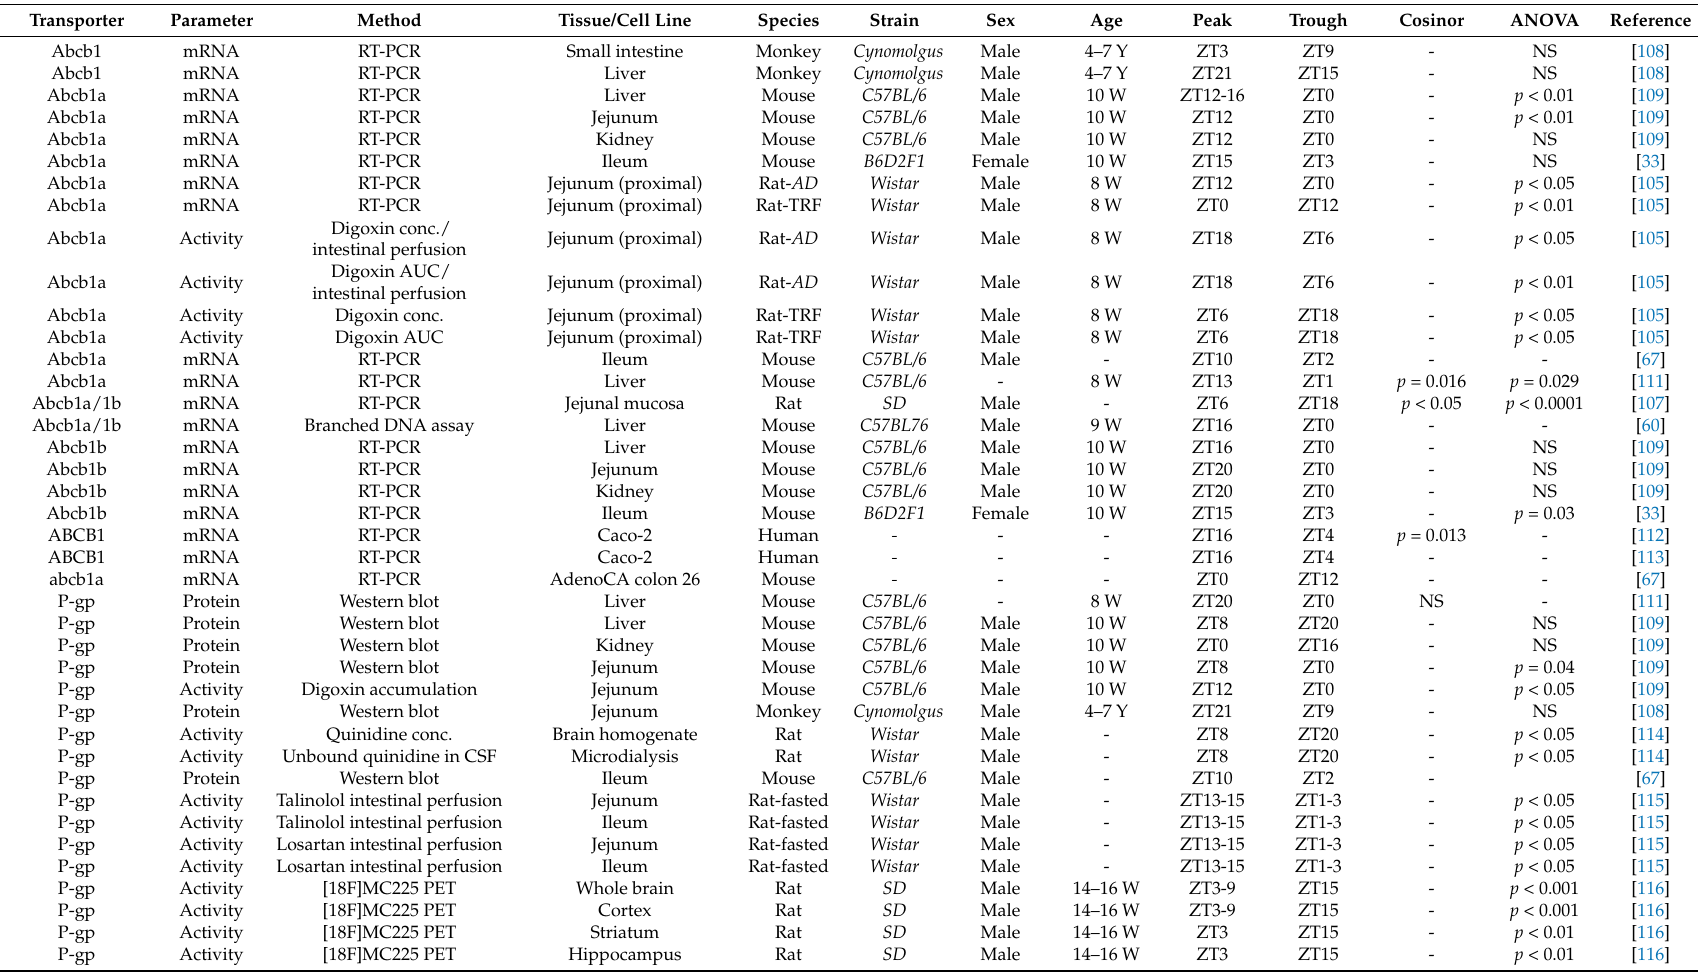
Table 2. This table summarizes the amount and activities of ABC transporter level at both molecular and biochemical levels in various circadian times in mammals along with rhythm parameters from different